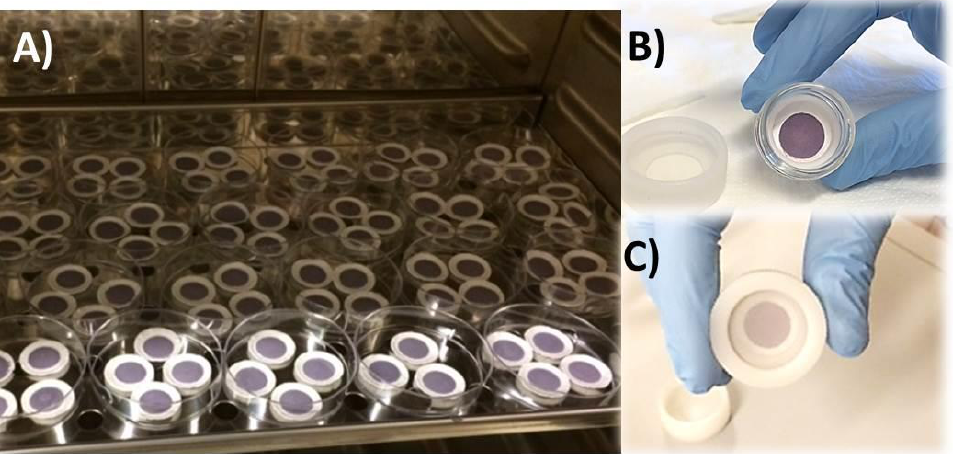
Figure 11. A fabrication step of the PAS devices: many of AuNPs-TiO 2 /quartz discs drop-deposited and placed in an oven to facilitate the solvent evaporation ( a ); the placement of the adsorbing disc on the borosilicate vessel bottom ( b ); the PAS device with the particulate filter mounted ( c ). After each exposure, using Equation (2), the sampling rate ( SR ) of each passive was calculated, and the relative results were reported in Table